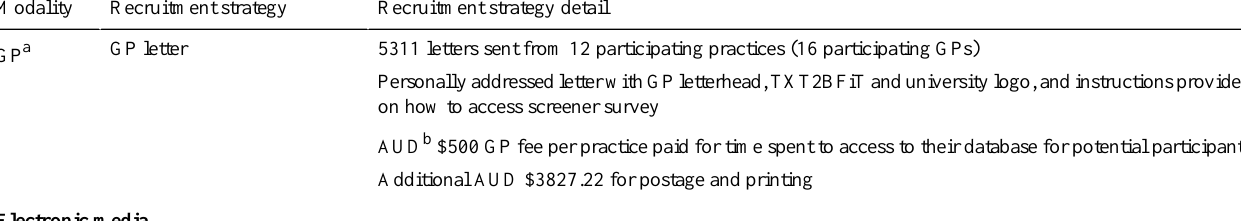
Table 1. TXT2BFiT recruitment strategy